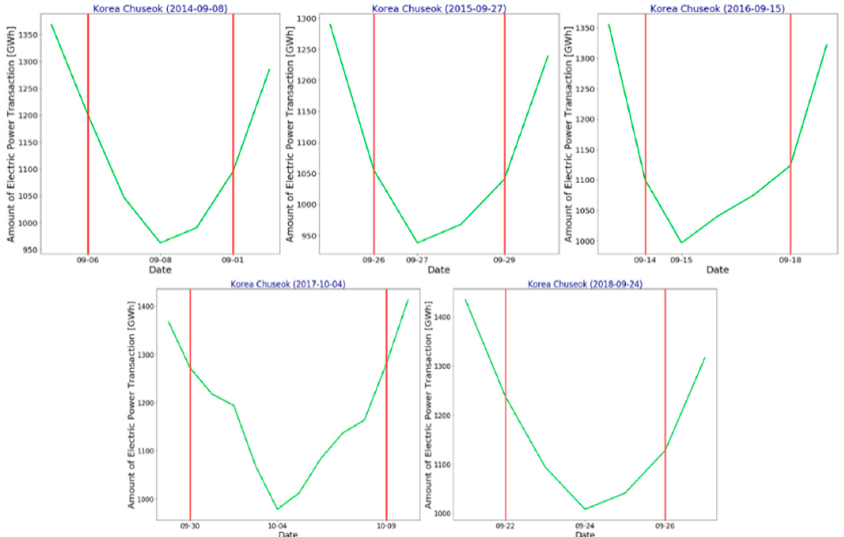
Figure 11. Thanksgiving holiday in South Korea during 2014–2018.